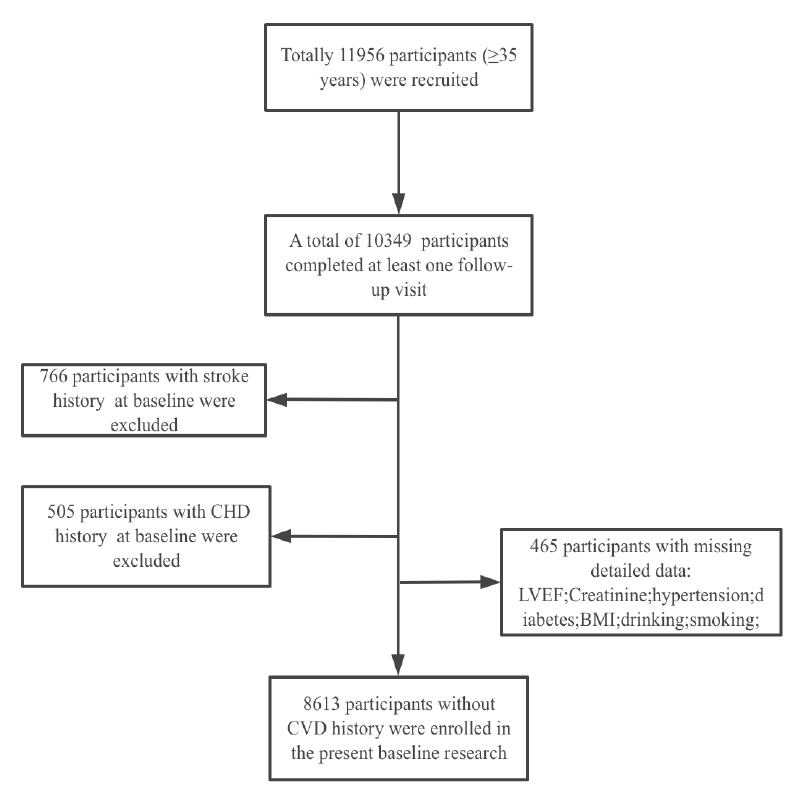
Figure 1. Flowchart illustrating the study population. A total of 10,349 participants were collected. total of 8613 participants without CVD history were A total of 8613 participants without CVD history were enrolled.